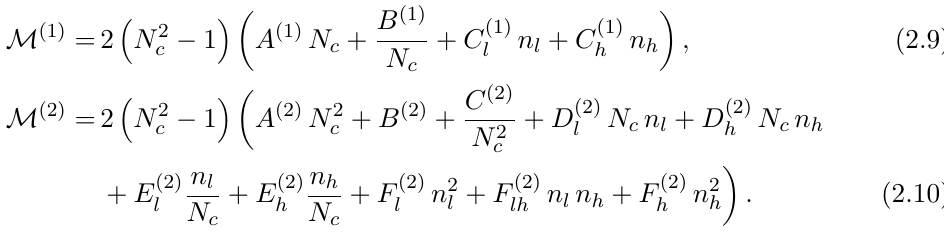
Figure 2 . One-loop Feynman diagrams for the process q ¯ q → Q ( q ), whilst thick ones indicate a heavy quark ( Q ); curly and dashed lines correspond to gluons and ghosts,